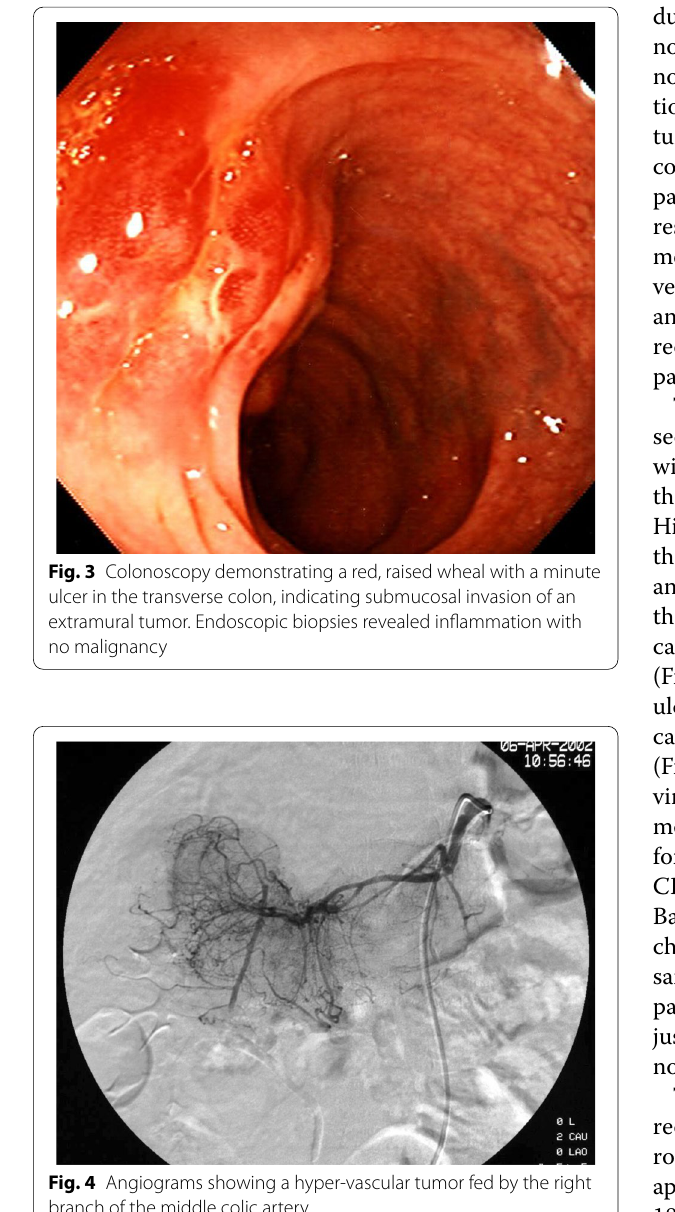
the middle colic artery (Fig 4). The SMV was poorly vis- ualized and narrowed. The tumor was not fed from any pancreatic or duodenal arteries. Upper gastrointestinal endoscopy showed no abnormality, including the papilla of Vater. Magnetic resonance cholangiopancreaticogram (MRCP) showed no abnormality in the pancreaticobiliary duct.